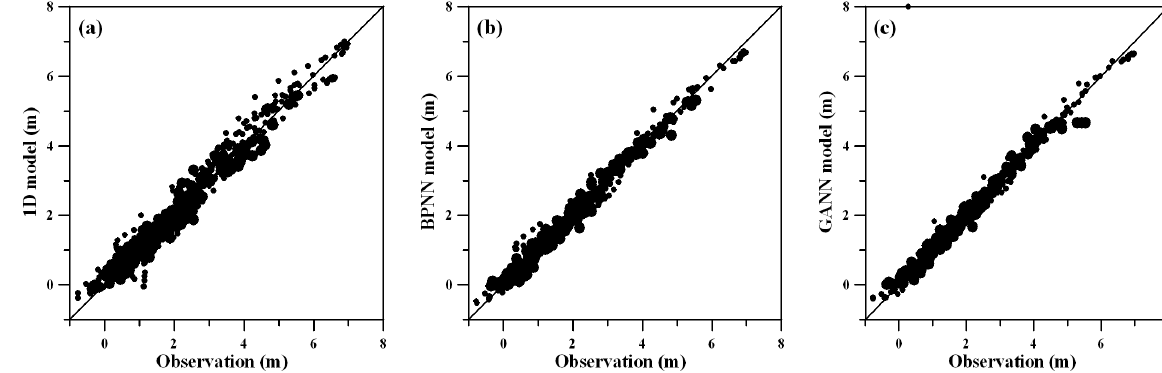
Figure 7. The scatter plots of simulated and observed water stages using ( a ) the one-dimensional flood routing hydrodynamic model; ( b ) the BPNN model; and ( c ) the GANN model for the calibration (training) phase for five typhoon events and four